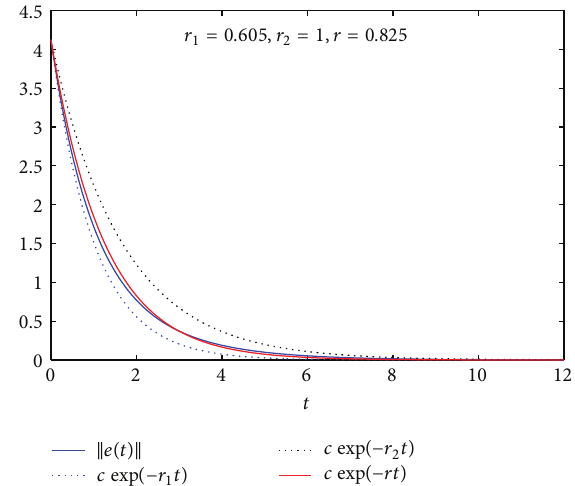
Figure 5: Comparison of the proposed “rate” curves with ‖𝑒(𝑡)‖ for synchronization using the tracking control technique ( 𝑐 = ‖𝑒(0)‖